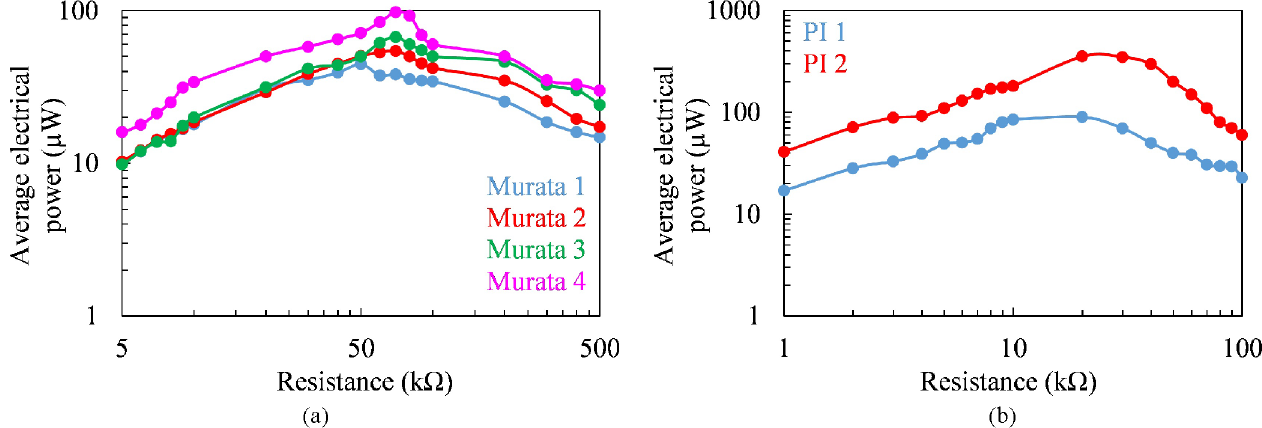
Fig. 15. Average electrical power produced by different piezoelectric structures during a hovering fl ight, with a 2600 mAh (169g) battery: (a) Murata buzzers, (b) PI DuraAct